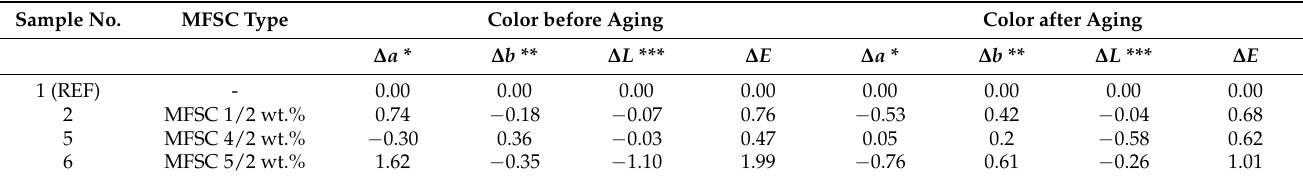
Table 5. ∆ L , ∆ a , ∆ b values and color ( ∆ E ∗ ) changes before and after aging. Sample No.